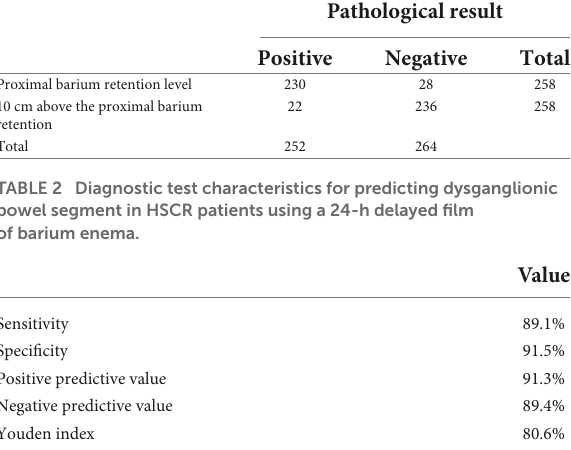
aganglionosis HSCR cases were 7.1% (3/42), 9.2% (14/153), and